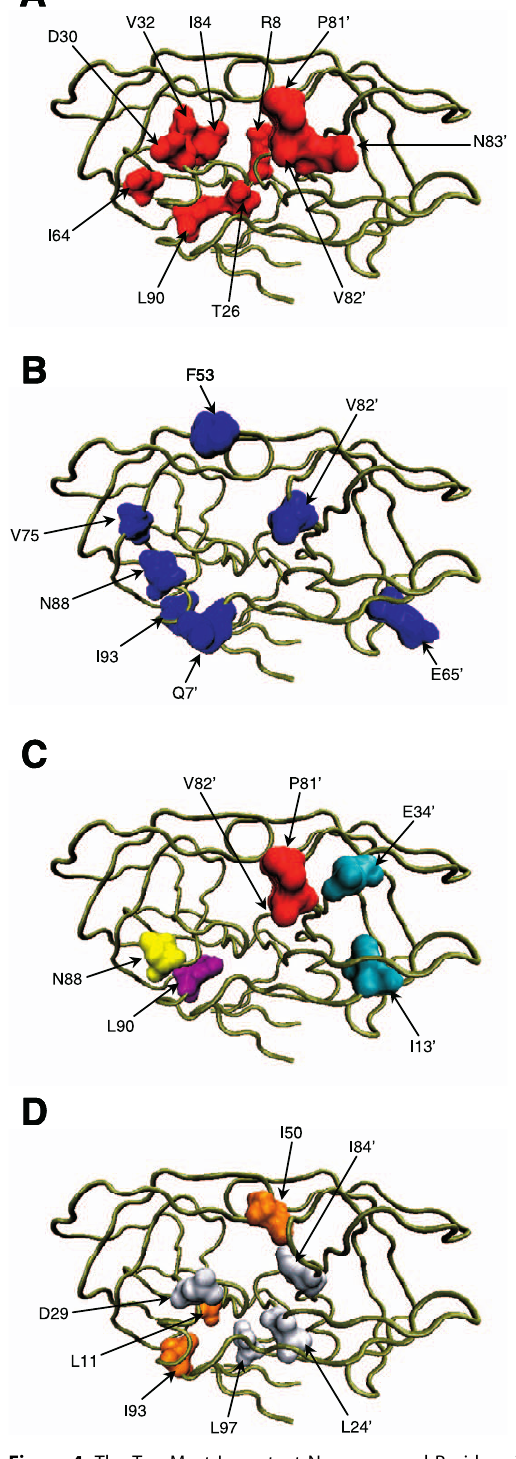
Figure 4. The Ten Most Important Nonconserved Residues in Retroviral Protease for Substrate Recognition and the Most Important Cross- Dependences of Retroviral Protease and Substrate Amino Acids Identified by Use of the CRM (A) The amino acids are shown in red on the 3-D structure of the HXB2 HIV-1 protease as a template. Because the retroviral proteases are homodimers, the modeling does not allow a distinction between